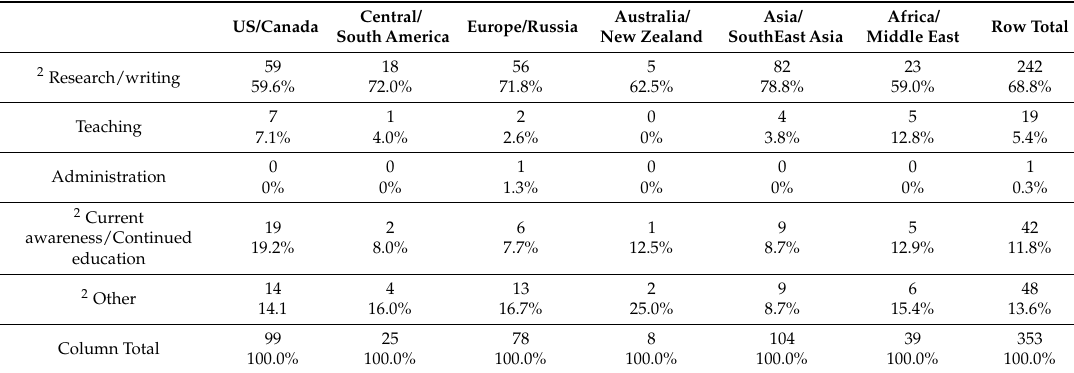
Table 28. Principal purpose of article reading by geographic